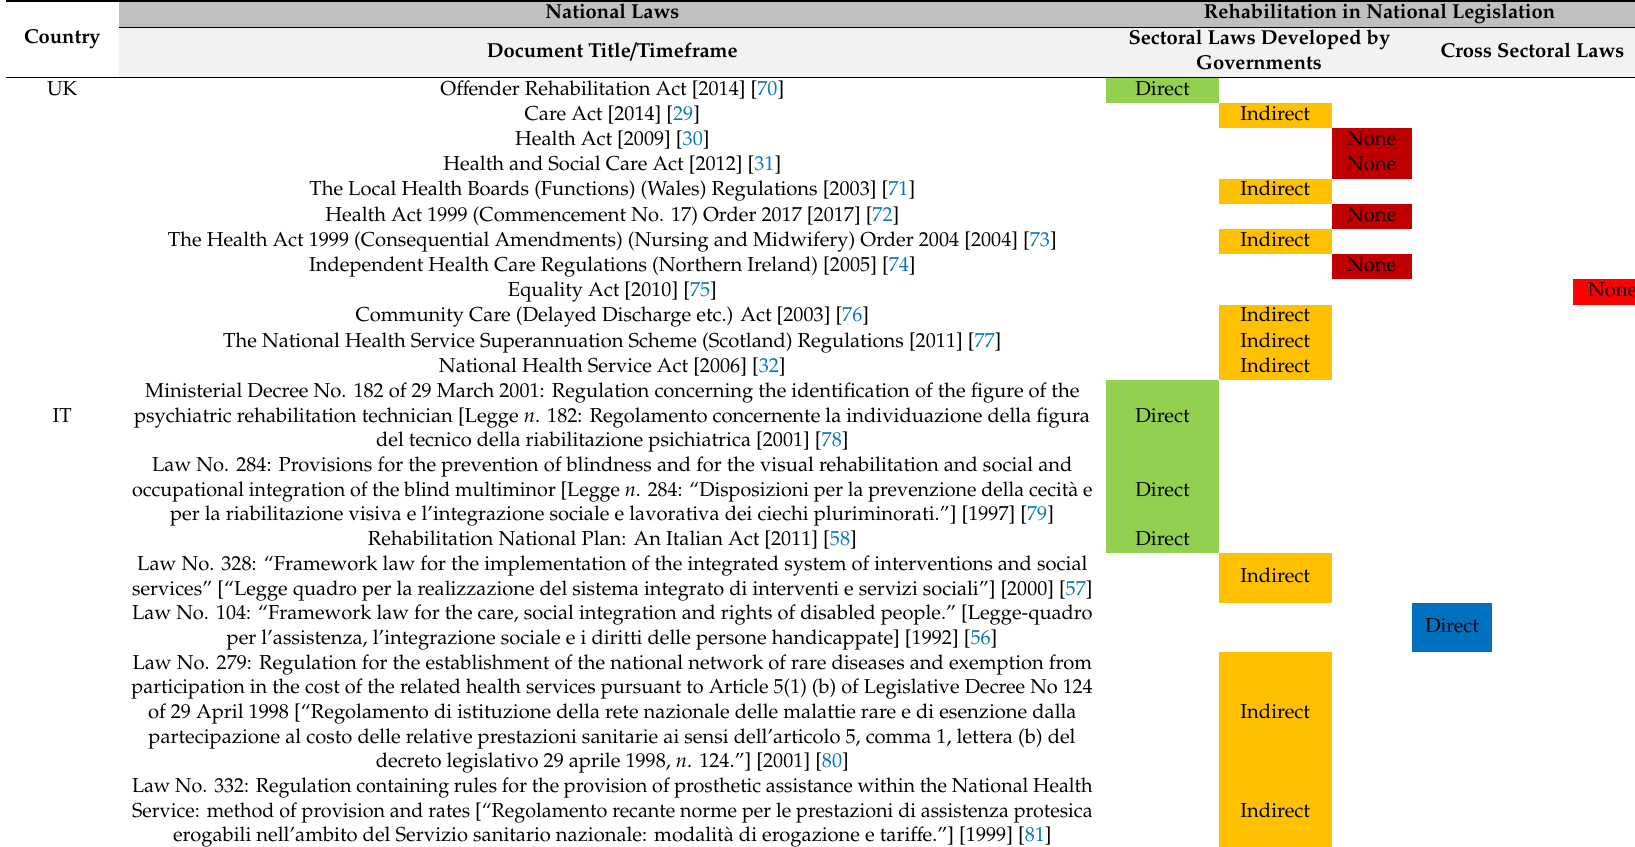
Table A1. Rehabilitation in national laws governing the provision of healthcare in five European countries ( n =